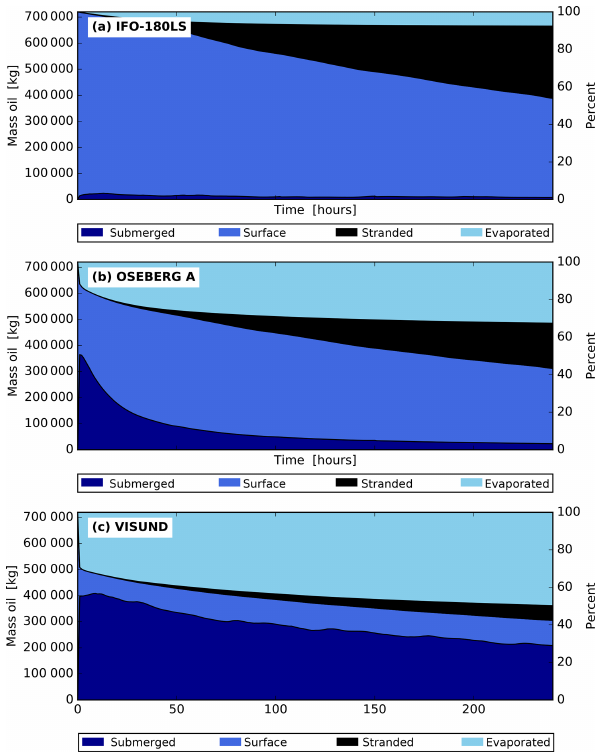
Figure 5. Composite mass budgets for 10-day simulations of three different oil types based on 72 ensembles for each oil